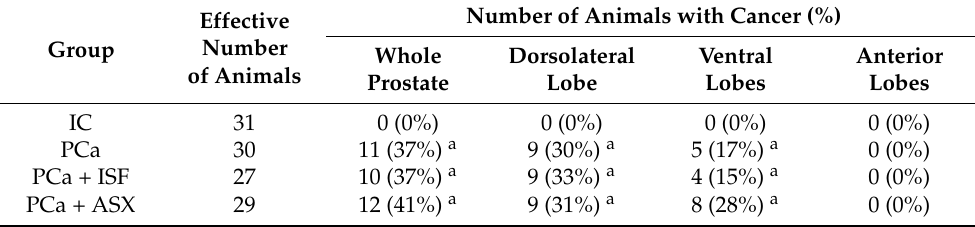
Table 2. Parameters of prostate carcinogenesis in rats treated with ISF and